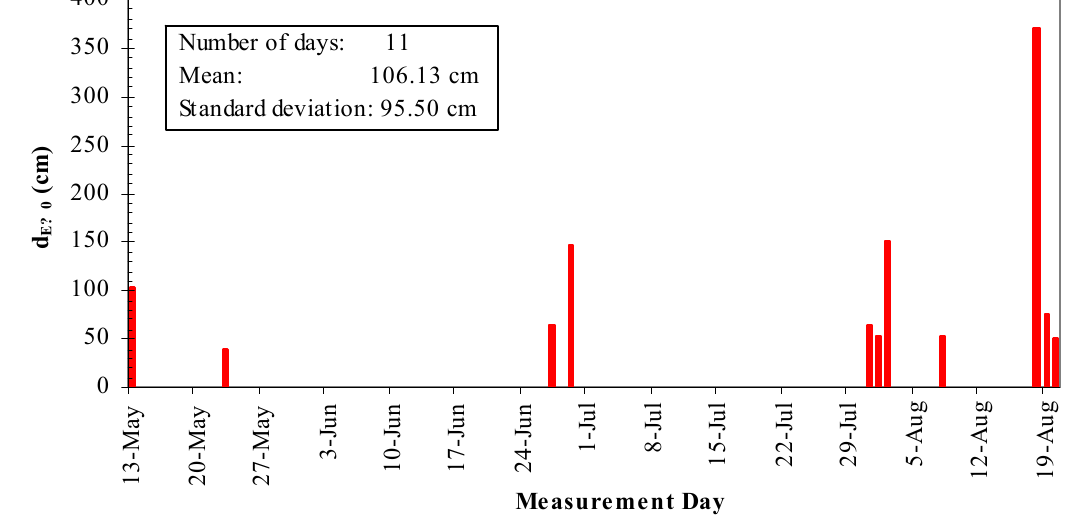
Figure 3. Thresholds of thickness of the dry soil layer (DSL), δ E → 0 in Equation (4), on the 11 measurement days at in the Horqin Sandy Land (after